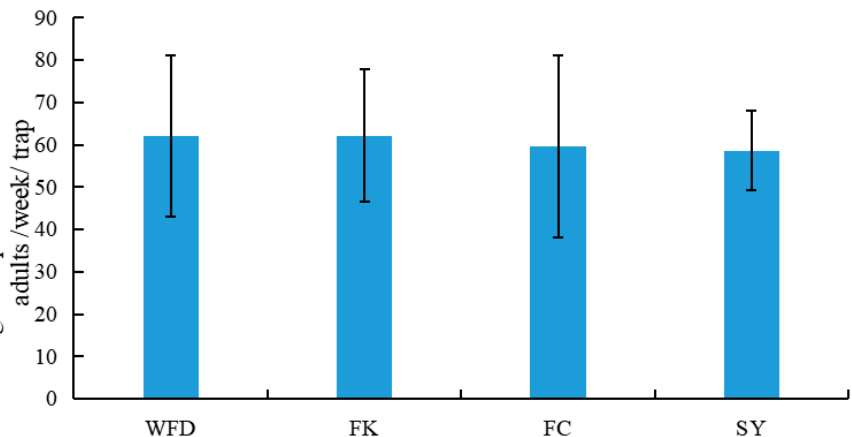
Figure 4. Weekly percentage (mean ± SE) of captured female D. suzukii adults at different locations. The population dynamics of D. suzukii adults were similar among the different loca- tions, with one capture peak in August and then a decrease to zero by October. The peak number of D. suzukii adults captured per week per trap was 259.88 in FC, significantly higher than those from other locations; and the peak amount of D. suzukii adults captured was 24.67 in SY, which was the lowest compared to other locations. The number of D. suzukii adults captured reached its peak on 07-22 (month-day), 08-02, 08-05, 08-17, at SY, WFD, FC, and FK, respectively, and decreased to zero on 08-07, 09-06, 10-01, and 10-05, at SY, WFD, FC, and FK, respectively (Figure 5, Supplementary Data